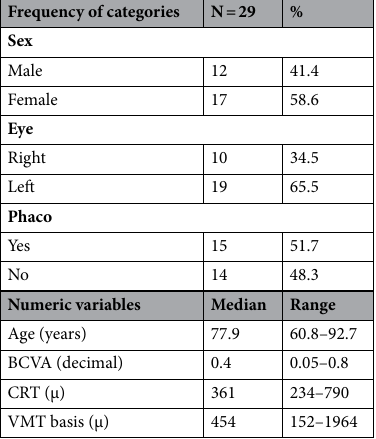
Table 1. Patients’ characteristics. BCVA best-corrected visual acuity, CRT central retinal thickness, VMT basis vitreomacular traction adhesion diameter.